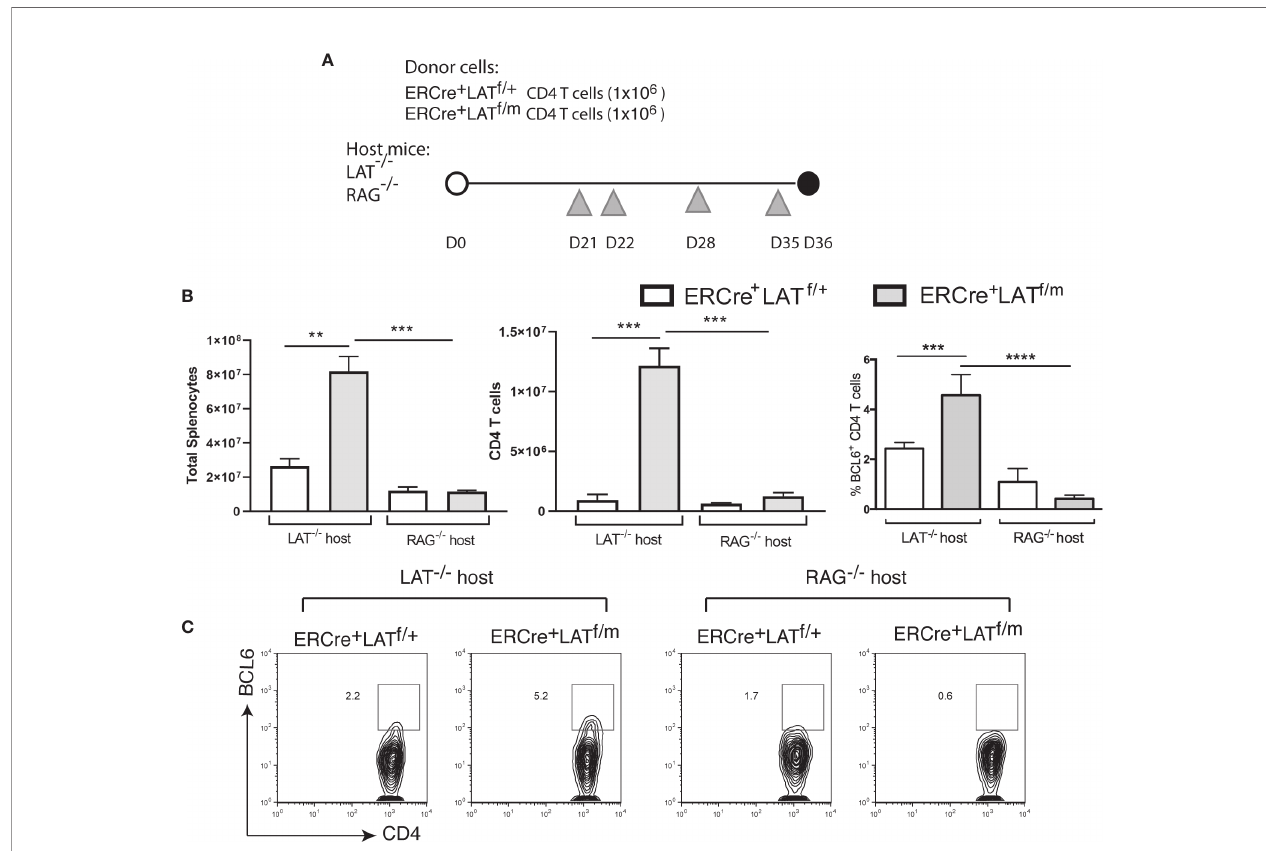
FIGURE 4 | The importance of B cells in Tfh cell differentiation in LATY136F mice. (A) 1x10 6 CD4 + T cells from ERCre + LAT f/+ or ERCre + LAT f/m mice were sorted and transferred into LAT -/- or RAG -/- hosts. Three weeks later, tamoxifen was injected at day 21, 22, 28, and 35 before being sacri fi ced on day 36. Grey triangles indicate the day of tamoxifen treatment. (B) Cell counts. Total numbers of splenocytes, CD4 + T cells in the spleens, and the percentage of CD4 T cells expressing BCL6. (C) Intracellular staining for BCL6. Data are representative of 2-3 individual experiments. One-way ANOVA; Tukey ’ s multiple comparisons **p < 0.005; ***p < 0.001; ****p <